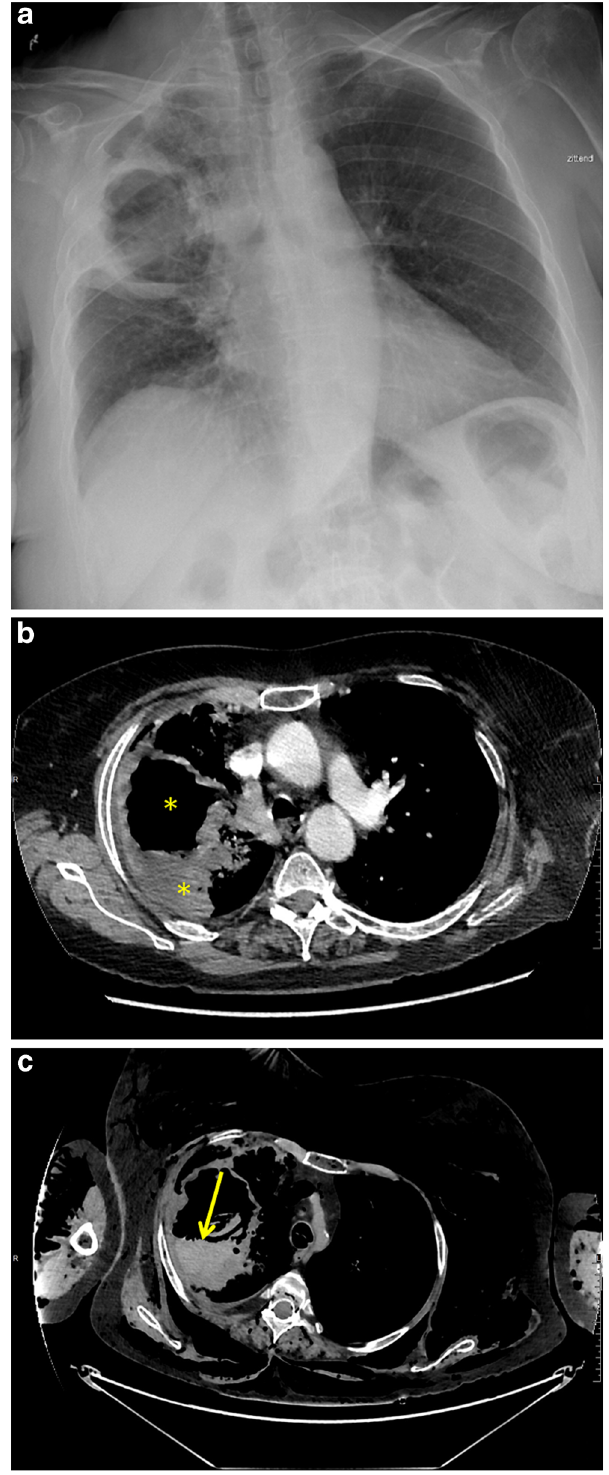
Fig. 5 Massive haemoptysis and fatal air embolism in a